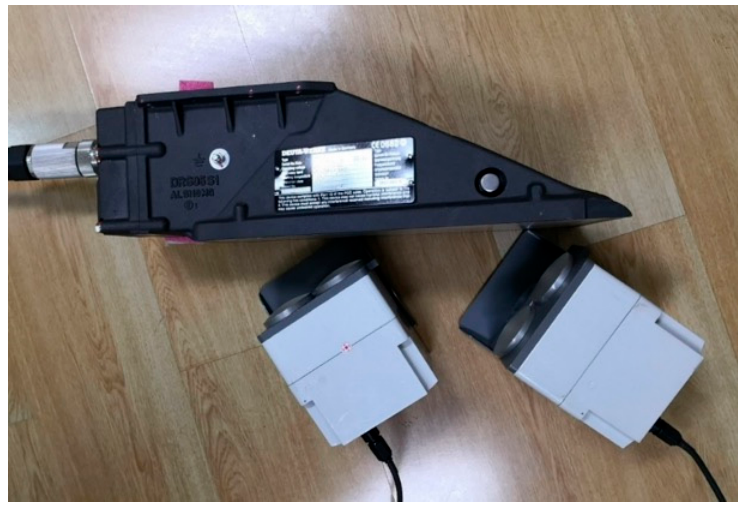
Figure 12. Calibration setup for the DRS05S1c sample.